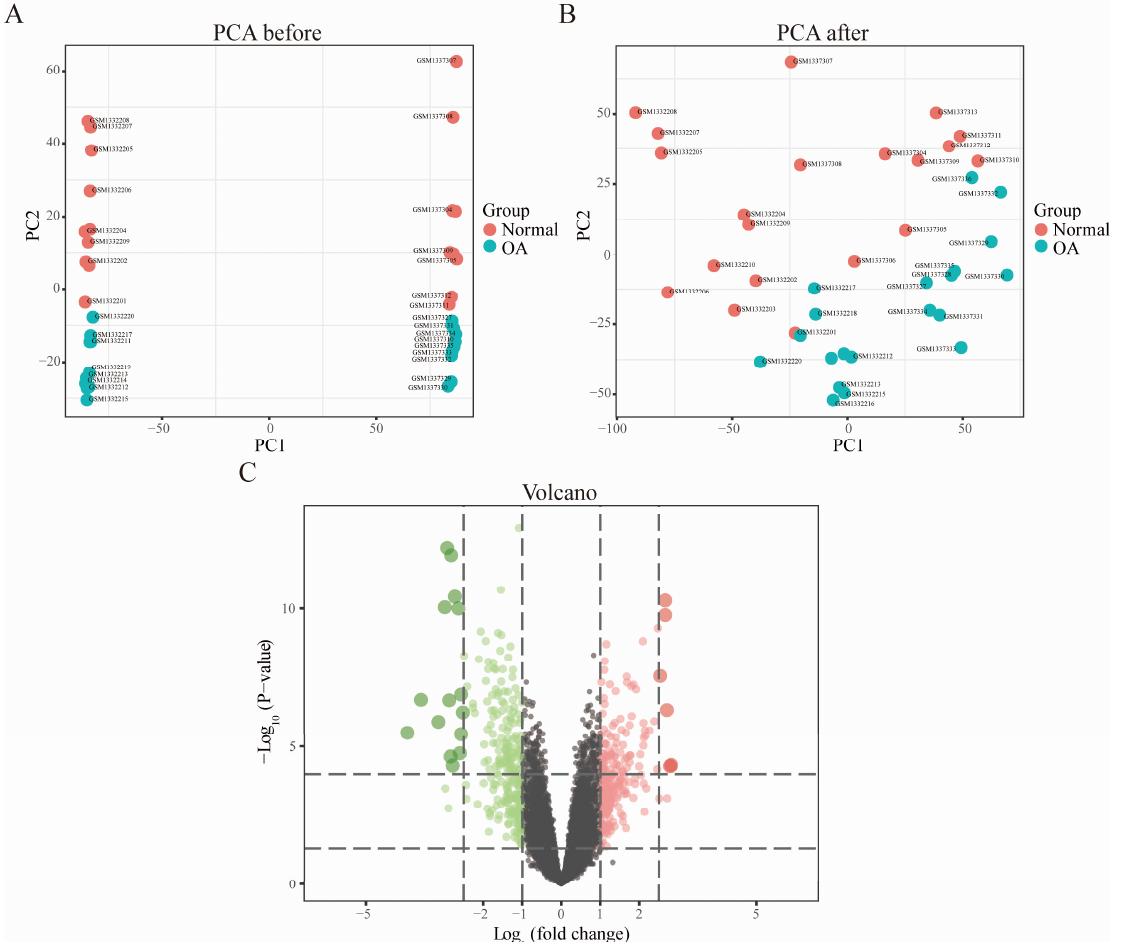
Figure 1. The quantile–quantile (Q-Q) plot of the inter-batch difference of GSE55235 and GSE55457 datasets is removed. The red line represents the density map of the GSE55235 data distribution, the black line represents the density map of the GSE55457 data distribution, and the black circles represent the quantiles corresponding to the same cumulative probability.